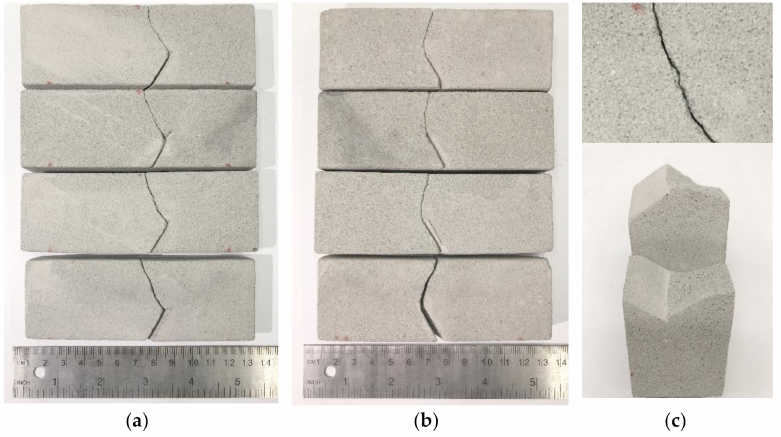
Figure 10. The fractured TPB-IC specimen when α = 30 ◦ and β = 30 ◦ . ( a ) The front of the fractured specimens. ( b ) The back of the fractured specimens. ( c ) A close view of fracture